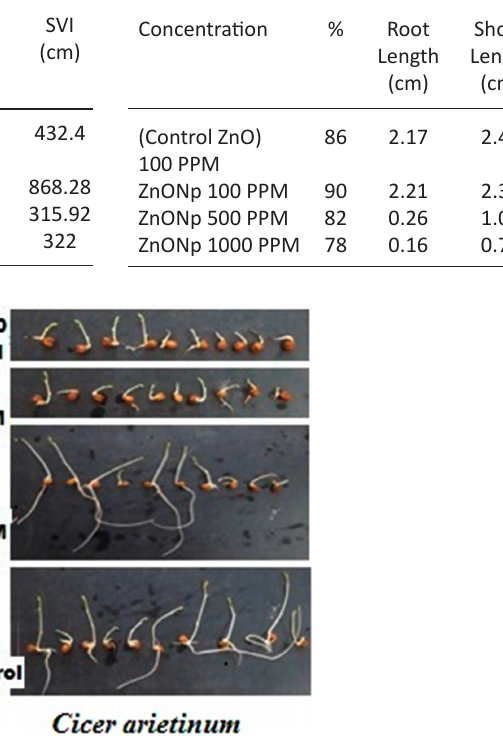
Fig.1 . Effect of ZnONp on seed germination of Lens esculentum Linn and Cicer